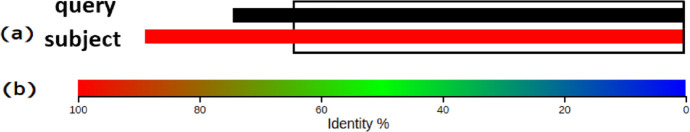
Entries CODON.(a) Graphical blast results for the entries on CODON, (b) Show the color scale used on analysis, query and subject.